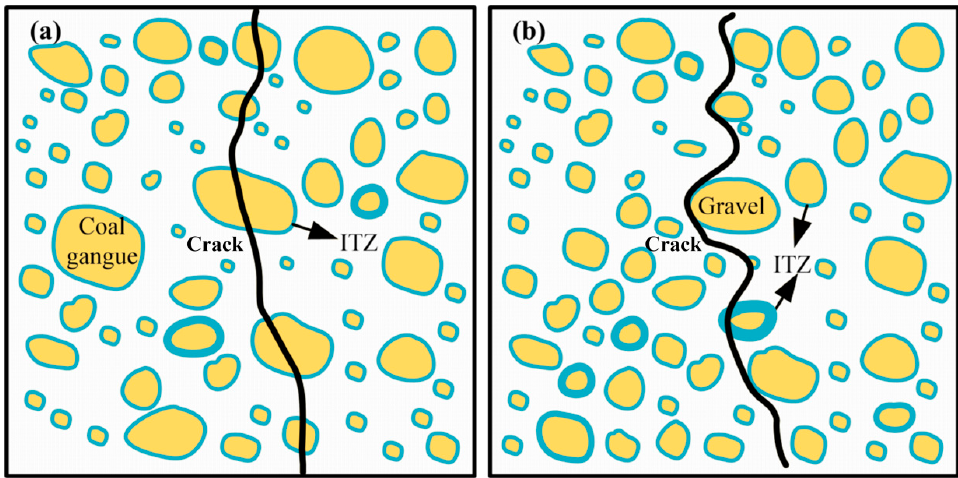
Figure 11. Internal failure pattern of ( a ) coal gangue aggregates and ( b ) crushed stone aggregates of alkali-activated coal gangue-slag concrete (ACSC).